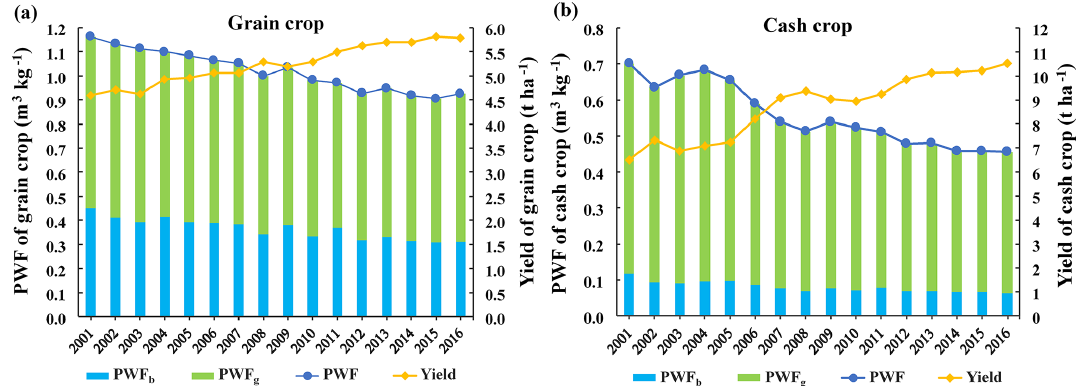
Figure 2. Interannual variability of national average production-based water footprint (PWF) of (a) grain and (b) cash crops in China over